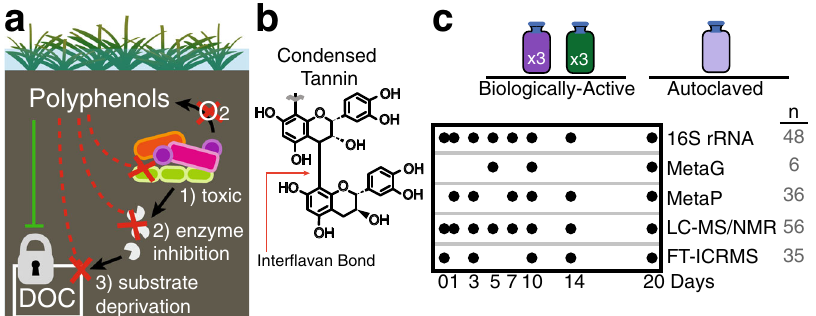
Fig. 1 Experimental framework using a model polyphenol to interrogate soil microbial metabolism. a Schematic summarizing the polyphenol lock paradigm 9,10 , demonstrating the ways these compounds may control microbial carbon transformations in anoxic soils. The green solid line indicates that in anoxic soils, polyphenols promote the lock on dissolved organic carbon (DOC). The dotted-red lines show the three proposed mechanisms by which polyphenols restrict the activity of soil microorganisms to lock soil carbon, including (1) toxicity to microorganisms, (2) inhibiting microbial extracellular enzymes, and (3) binding and depriving microorganisms of nutrients. b A puri fi ed condensed tannin (CT) was selected as the model polyphenol in this study due to its inferred lack of microbial degradation in anoxic soils 7 . This model compound is well characterized chemically 21 and has an average degree of polymerization of 16, where inter fl avan bonds (red arrow) connect monomers of epicatechin with a single catechin monomer cap. c The experimental design included soil reactors from three treatments (i) Biologically-active CT amended (dark purple), (ii) Biologically-active unamended control (green), and (iii) CT-amended autoclaved control (light purple). Autoclaved soils only included metabolite analyses, while microbially-active soils were analyzed with the suite of multi-omics approaches. The timepoints of each type of analysis are shown, with the total number (n) of samples across treatments denoted on the right in